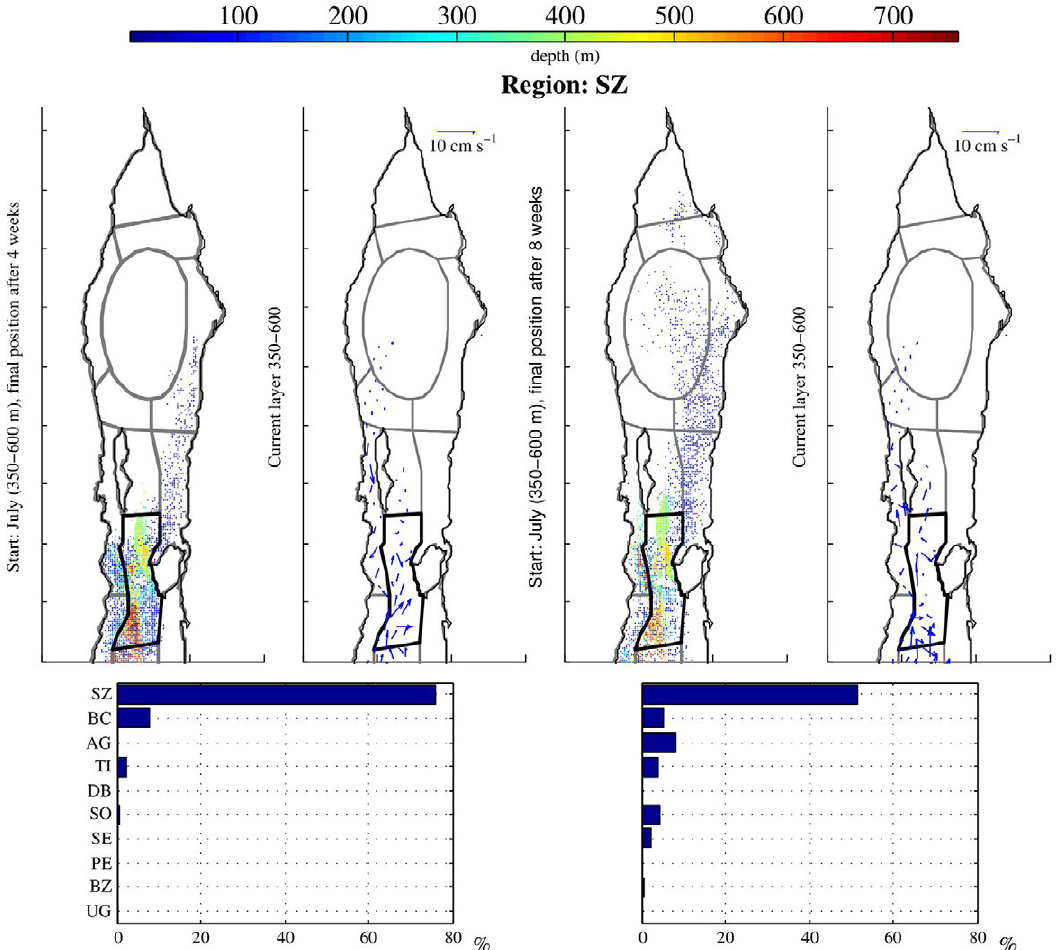
Fig. 10. – Map of final position of particles released in the Sills Zone’s tenth layer, in the fourth and eighth week after the release of particles. The release area is shown in black and the other areas in grey polygon. The colour bar represents the depth at which each particle is located. The histogram shows the percentage of particles retained or transferred to other regions. Current maps correspond to the layer in which the percentage of particles retained is concentrated, in the fourth and eighth week after particle